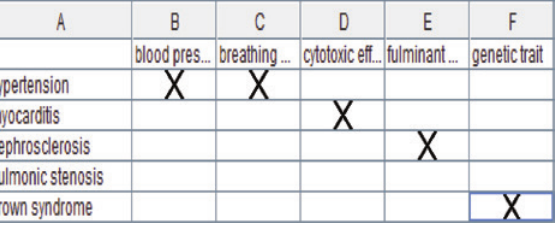
Figure 5: Part of a Formal Context Generated from the Original Dataset Using Our Proposed Method.